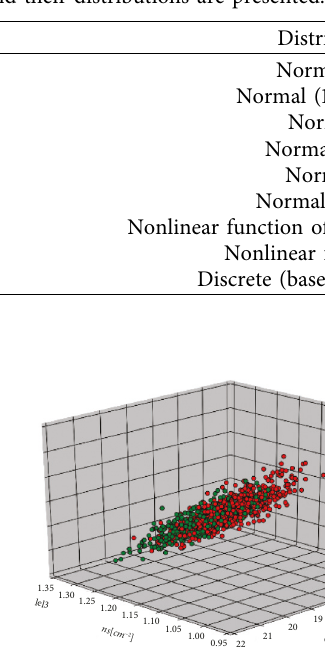
Figure 4: Distribution of I dss for 1000 AlGaN/GaN HEMTs fab- Figure 6: Relationship between saturate drain current, electron ricated at WUST. mobility, layer thickness, and electron concentration of AlGaN/ GaN HEMT with stochastic complexity being